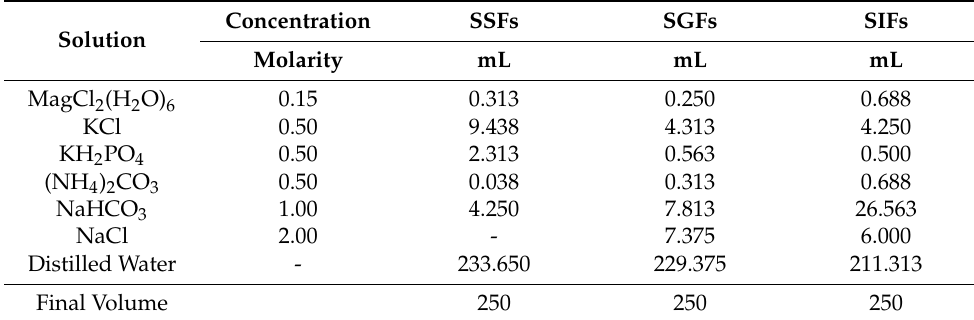
Table 1. Details of the fluids used in the simulated gastrointestinal